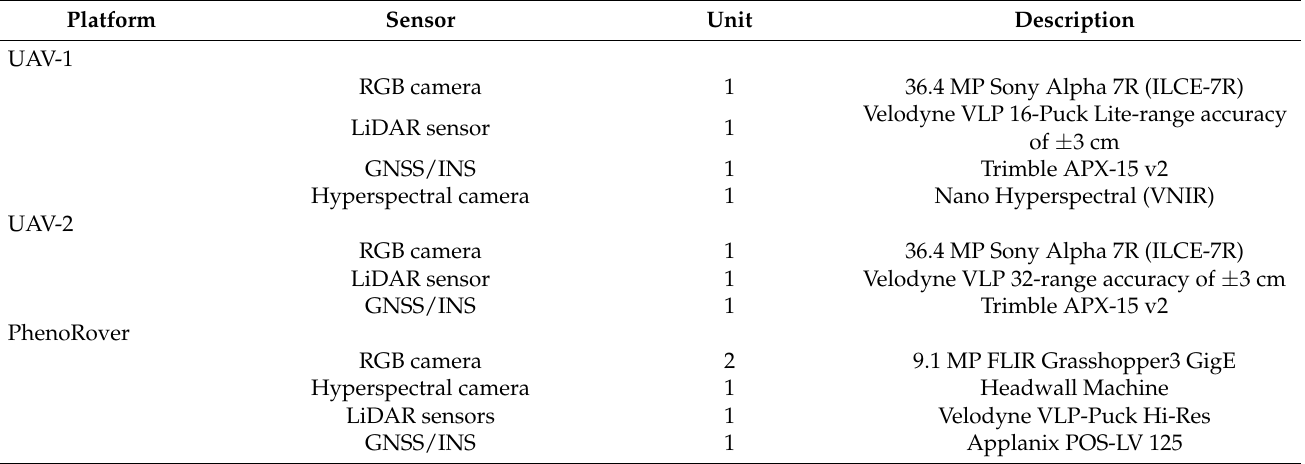
Figure 5. ( a ) PhenoRover platform with RGB/LiDAR/Hyperspectral/GNSS/INS sensors, ( b ) UAV-2 with RGB/LiDAR/GNSS/INS sensors. Table 2. Platforms’ and mounted sensors’